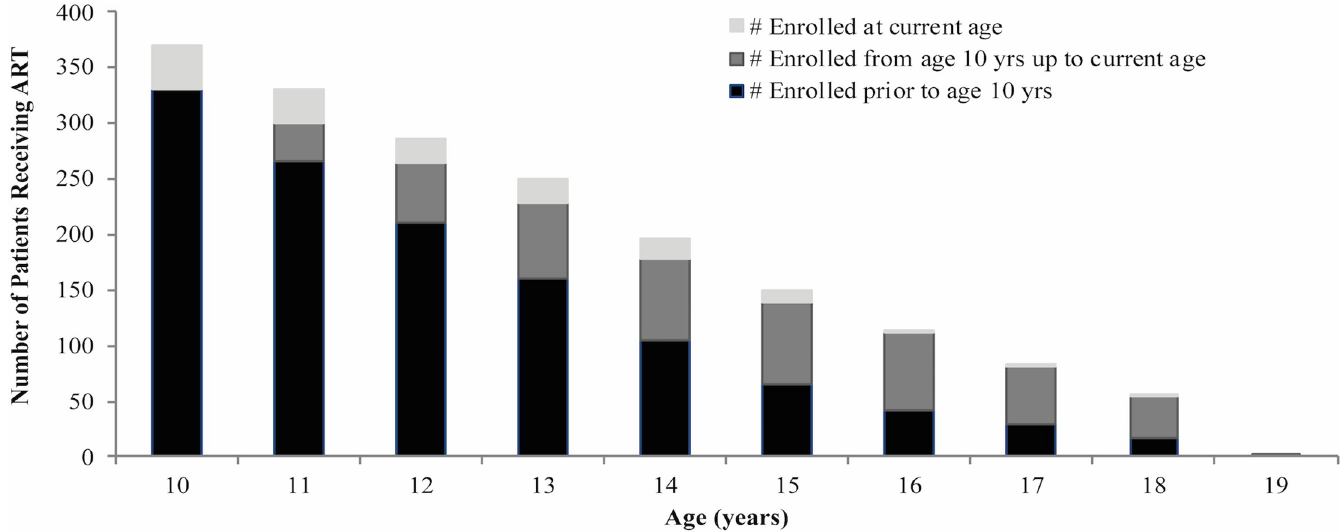
Fig 2. Number of patients that received treatment during adolescent years by age, stratified by age at ART initiation.